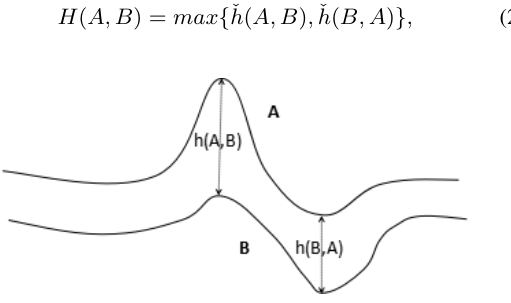
Figure 1: Hausdorff distance between A and